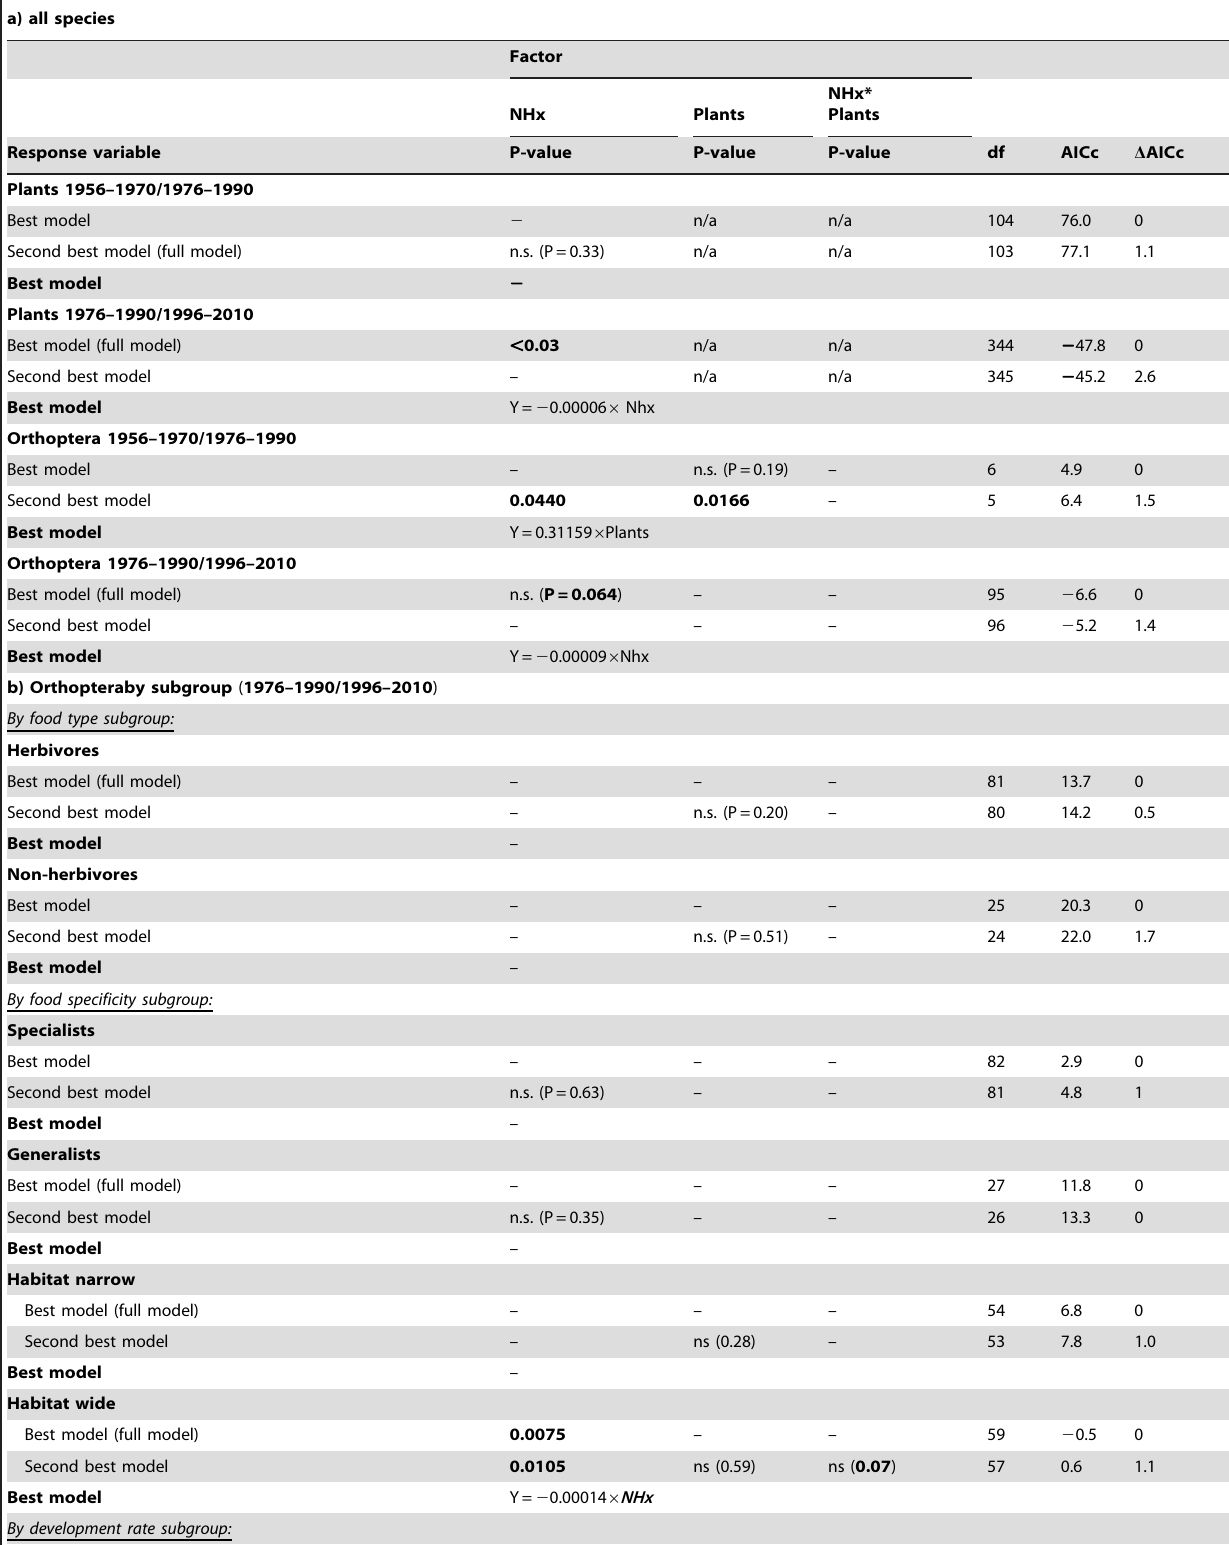
Table 2. Effect of Ammonia andPlants on Orthoptera